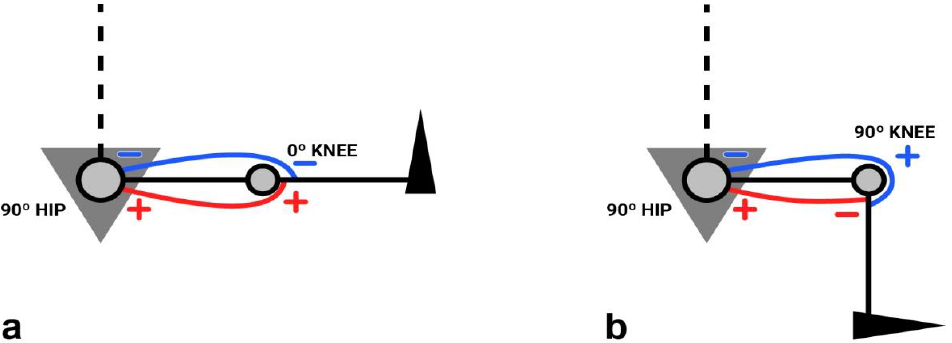
Figure 1. Diagram showing the difference in pretension between the quadriceps and hamstring muscles when the knee is in extension ( a ) and flexion ( b ). The “+” and “ − ” signs, which can be seen in both the areas of origin and insertion of the muscles, represent high pretension (+) and low pretension ( − ). The red lines symbolize the hamstring muscle, and the blue lines symbolize the quadriceps